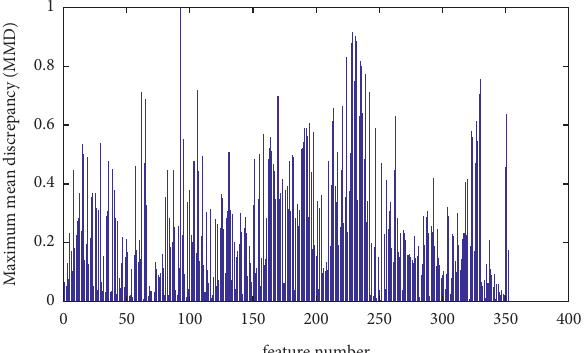
Figure 11: The maximum mean discrepancies of 352 features.